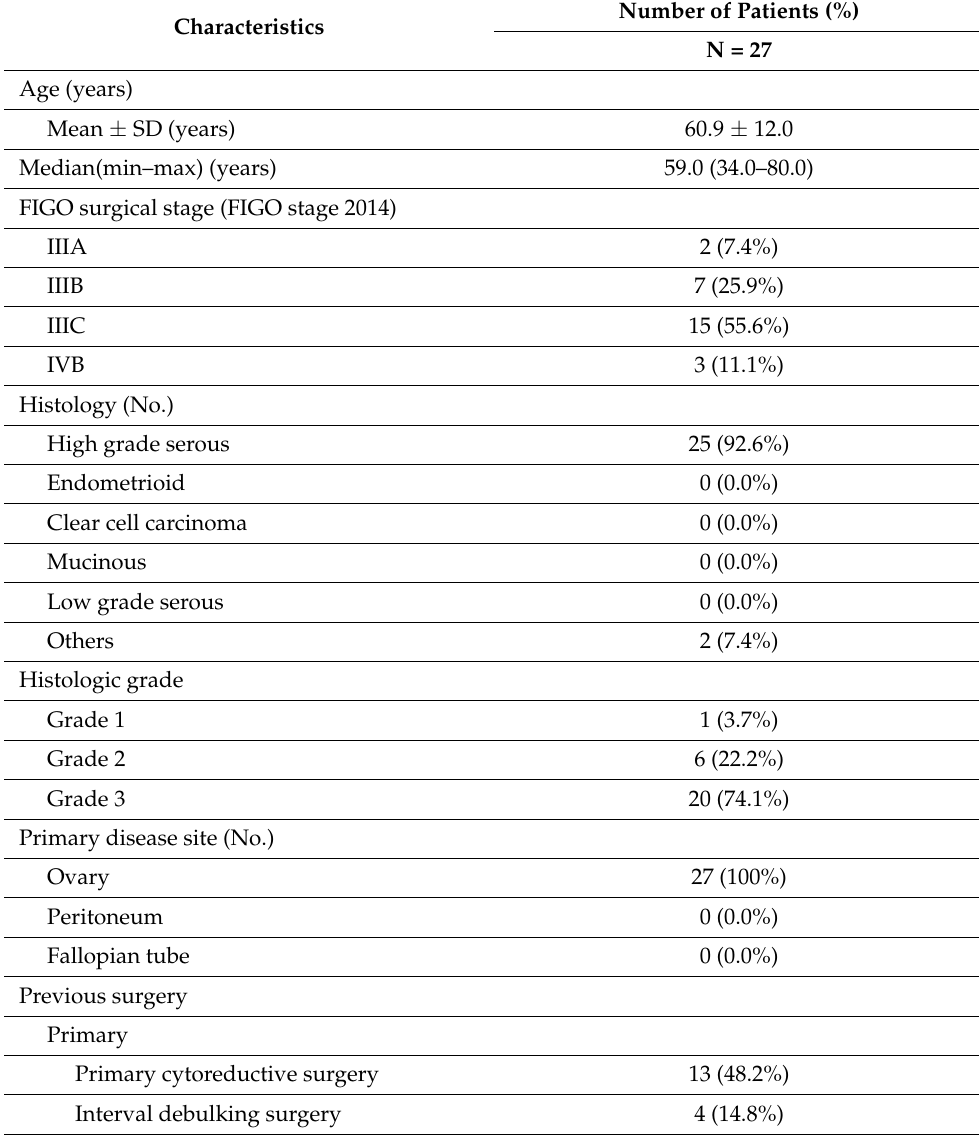
Table 1. Patient and baseline disease